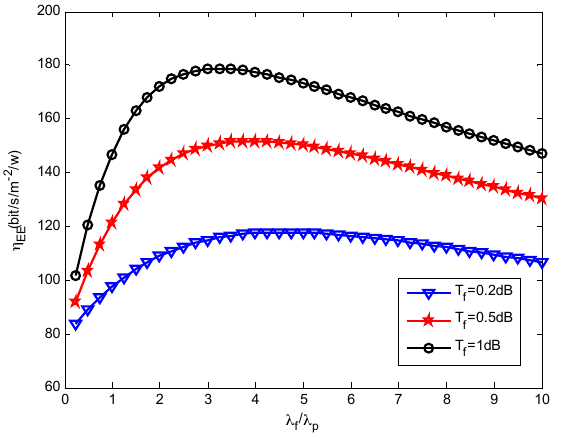
Figure 5. Energy efficiency vs. SBS density ratio when T p = 3.5 dB. Sensors 2016 , 16 , 1854